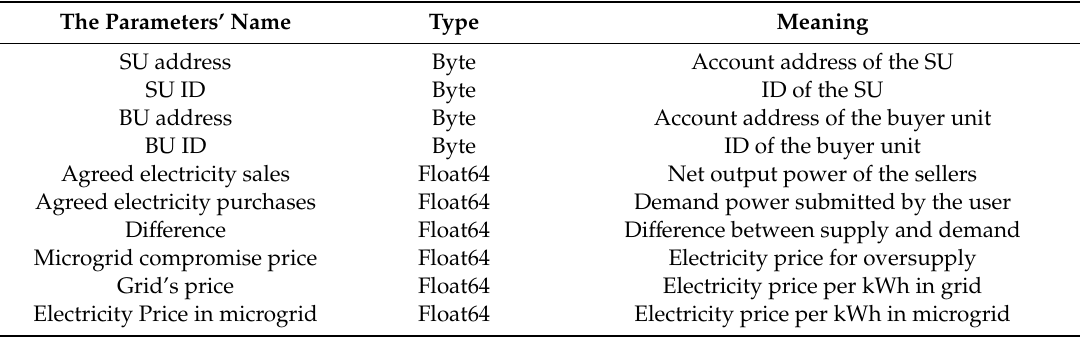
Table 6. Basic elements of supply and demand compensation